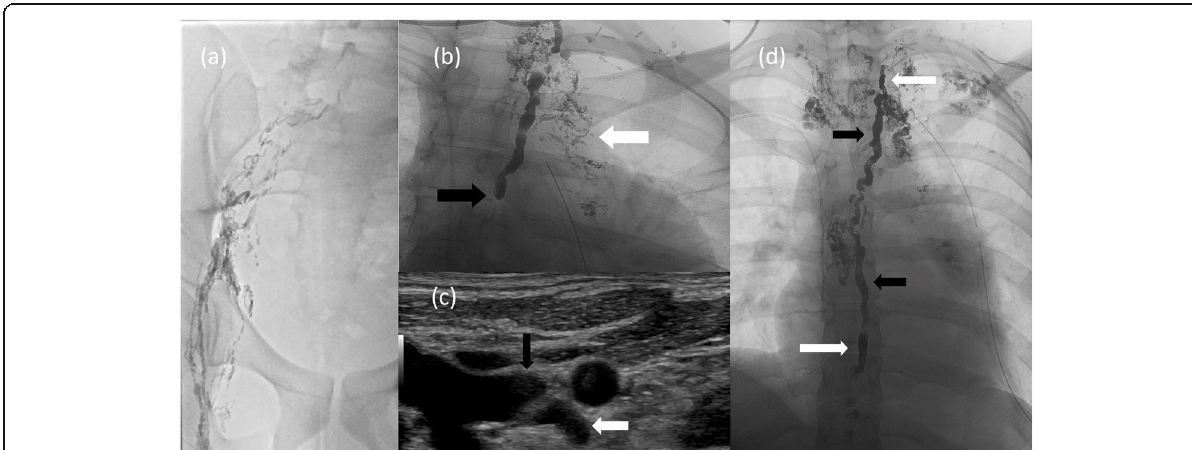
Fig. 2 Intra-procedural findings. Lymphangiogram after ethiodol injection into a groin lymph node (a) revealed abnormal dilated and tortuous lymphatic channels in the right iliac chain. Fluoroscopic image (b) of the upper chest demonstrated a partially opacified thoracic duct terminating abruptly at the inferior margin (black arrow) and multiple abnormal, irregular lymphatic channels (white arrow) in the mediastinum corresponding to the CT image in Fig. 1. The abrupt termination was likely due to a valve. This was crossed without much difficulty with a microsystem. Grayscale ultrasound image (c) of the thoracic duct (white arrow) draining into the left subclavian vein (black arrow) at the venous angle. Intra-procedural fluoroscopic image (d) of the thoracic duct demonstrating embolization coils (white arrows) at the inferior and superior aspects of the duct. The intervening segment of thoracic duct was embolized with radiopaque NBCA (black arrows). A left chest tube and right